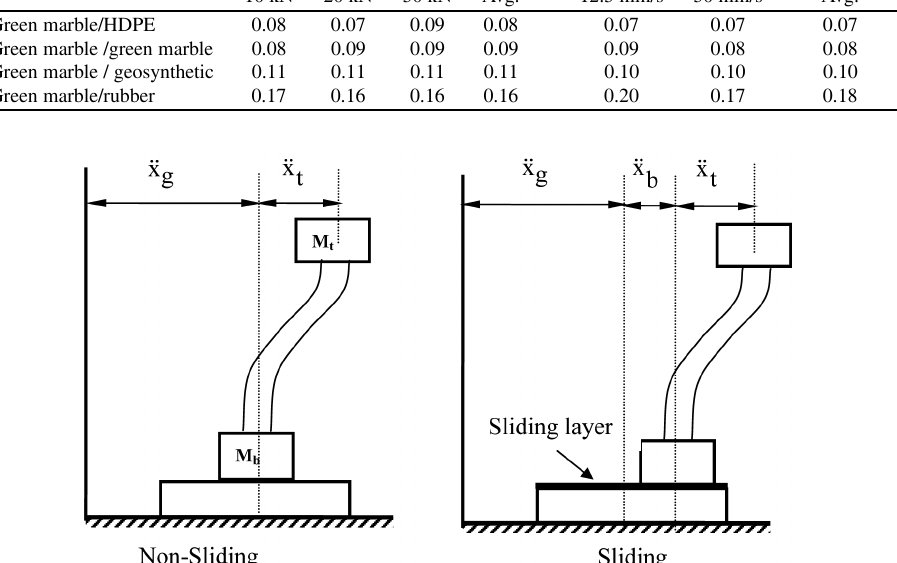
Fig. 5. Mathematical model for system with a non-sliding and sliding